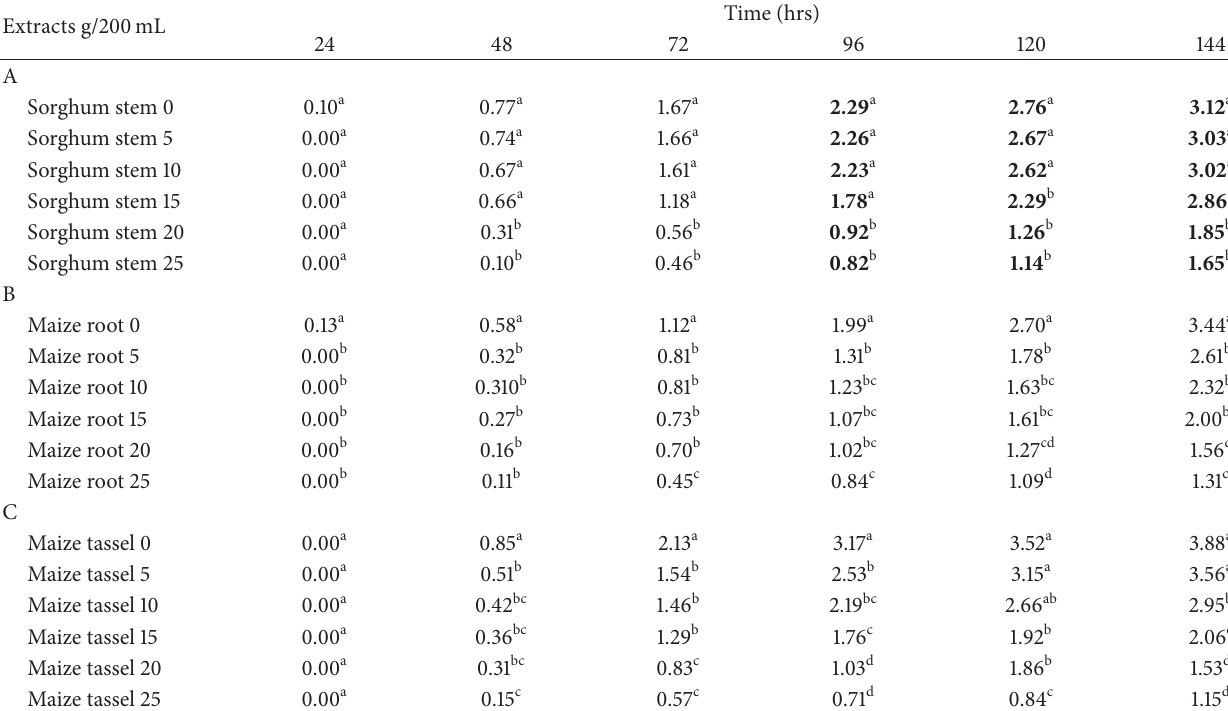
Table 2: Effects of aqueous extracts of sorghum stem and maize (roots and tassel) on the radicle length (cm) of seeds of okra. Extracts g/200